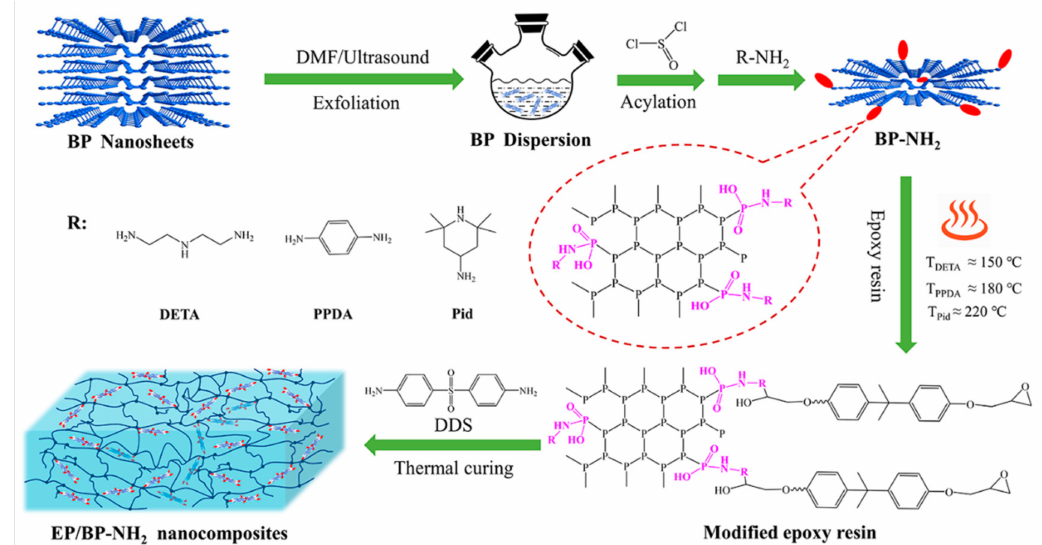
Figure 1. The preparation process of BP-NH 2 nanofiller and EP/BP-NH 2